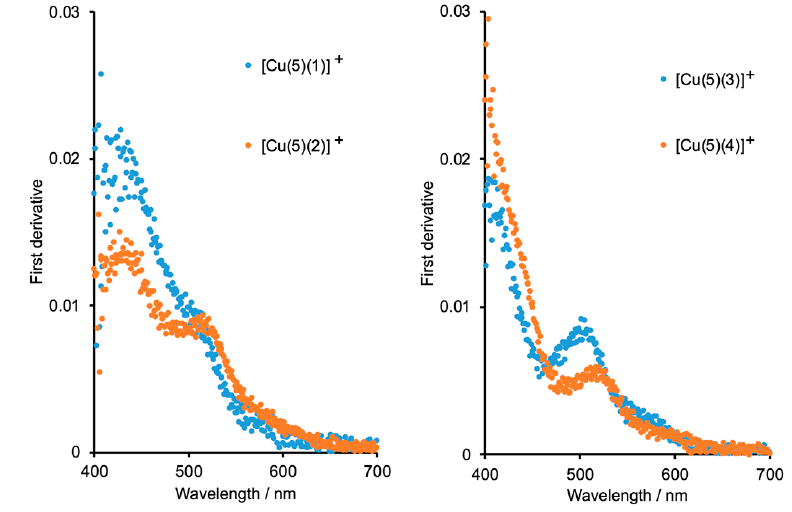
Figure 6. First-derivative solid-state absorption spectra of transparent FTO / TiO 2 electrodes functionalized with the [Cu( 5 )(L)] + dyes (L = 1 , 2 , 3 and 4 ). + DFT calculations on [Cu( 5 )( 2 )] show that the orbital compositions of the HOMO and HOMO–1 contain both metal and ancillary-ligand character, while the LUMO is localized on the anchoring ligand 5 (Figure 4b); the LUMO + 1 exhibits mainly ancillary ligand bpy character. Similar orbital characters + are revealed for [Cu( 5 )( 1 )] (Figure S38 in the Supporting Information), indicating that the frontier orbital characteristics of the heteroleptic dyes are not significantly perturbed by the presence of the alkynyl spacers. Thus, the localization of LUMO character on the anchoring domain is consistent with what is desired for e ffi cient electron injection from the anchoring ligand to the semiconductor in a DSC. + Table 1 summarizes the performances of sets of four DSCs sensitized with the dyes [Cu( 5 )( 1 )] + and [Cu( 5 )( 2 )] compared with the performance of a DSC containing the reference ruthenium(II) dye N719. In the final column of Table 1, we present relative e ffi ciency values with N719 set at an arbitrary 100%. We [57] and others [58,59] find it useful to include relative values so as to permit valid comparisons of data recorded on di ff erent solar simulators or in di ff erent laboratories [57]. The first point to note in Table 1 is the reproducibility of the DSC performance parameters for a given sensitizer. This is also observed in the J–V ( J = current density, V = voltage) plots in Figure 7 and + Figure S39. The most noticeable feature is that the DSCs containing [Cu( 5 )( 2 )] have both lower J SC + and V OC values than those with [Cu( 5 )( 1 )] , indicating that the introduction of the alkynyl spacer in 2 + is not beneficial. The PCEs for DSCs sensitized with [Cu( 5 )( 1 )] are in the range 1.66–1.79%, which corresponds to 31.0–33.4% of the PCE of the reference DSC containing the ruthenium(II) dye N719. Figure 8 and Figure S40 show the external quantum e ffi ciency (EQE) spectra for the cells in Table 1, + with values of λ max ≈ 490 nm and EQE max ≈ 38% for [Cu( 5 )( 1 )] , and λ max ≈ 470 nm and EQE max ≈ + 34% for [Cu( 5 )( 2 )] . These data are consistent with the di ff erences in the J–V curves for the two